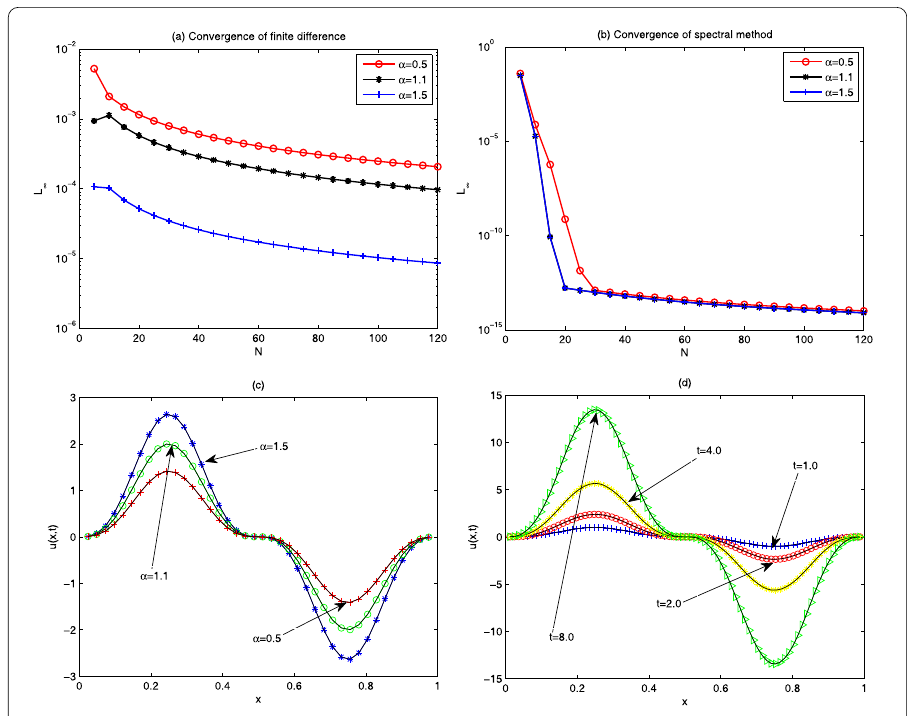
Figure 1 Solution of fractional-in-space diffusion equation (3.24) showing the trade-off between finite difference and Fourier spectral methods at different instances of α and simulation time t , for D = 10.